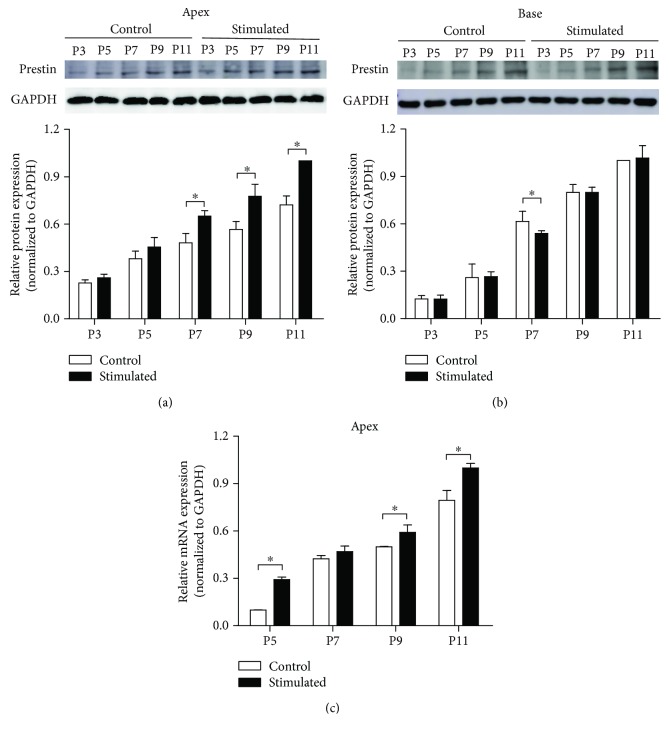
Low-frequency sound environment enhances the expression of prestin in OHCs in the apical turns. (a) Prestin protein expression is increased in the apical organ of Corti after low-frequency sound environment stimulation. Upper panel: immunobands of prestin from the apical organ of Corti at different postnatal ages. Lower panel: normalized prestin expression level. (b) Prestin protein expression is unchanged in the basal organ of Corti after sound environment stimulation. Upper panel: immunobands of prestin at different postnatal ages. Lower panel: normalized prestin expression level. (c) Normalized prestin mRNA level is increased in the apical organ of Corti after sound stimulation. All data points represent the mean ± standard deviation. ∗p < 0.05. OHC: outer hair cell.